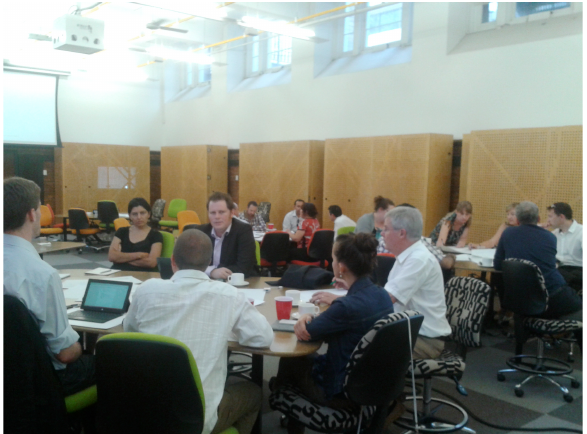
Figure 5: Workshop focused on the Co-design ‘generative’ stage of the precinct tool